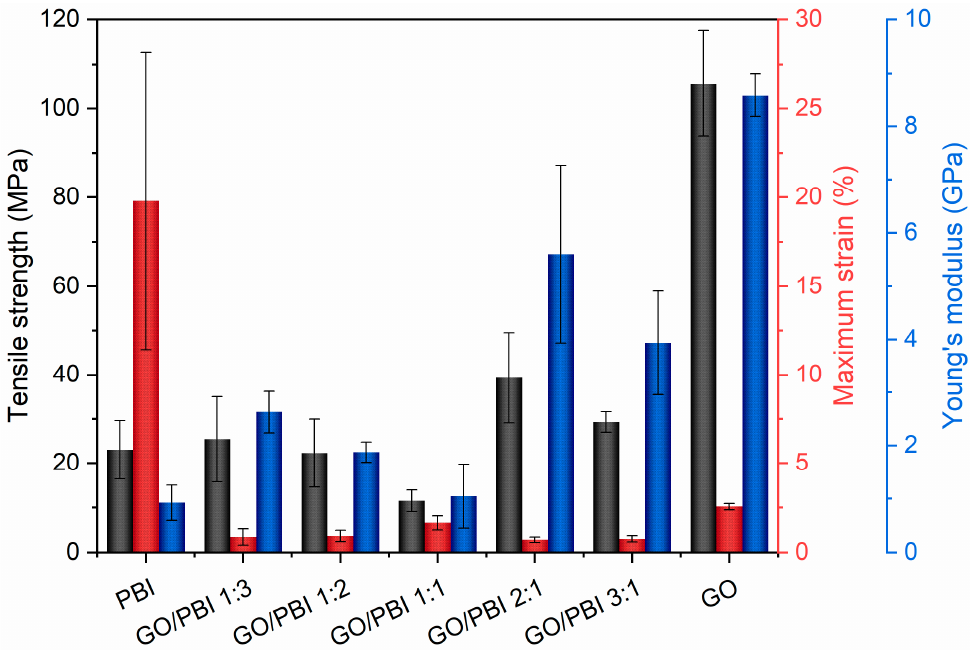
Figure 6. Values of tensile strength (black), maximum strain (red), and Young’s modulus (blue) extrapolated from tensile tests performed on the GO/PBI X:Y composites, pure GO, and pure PBI membranes.